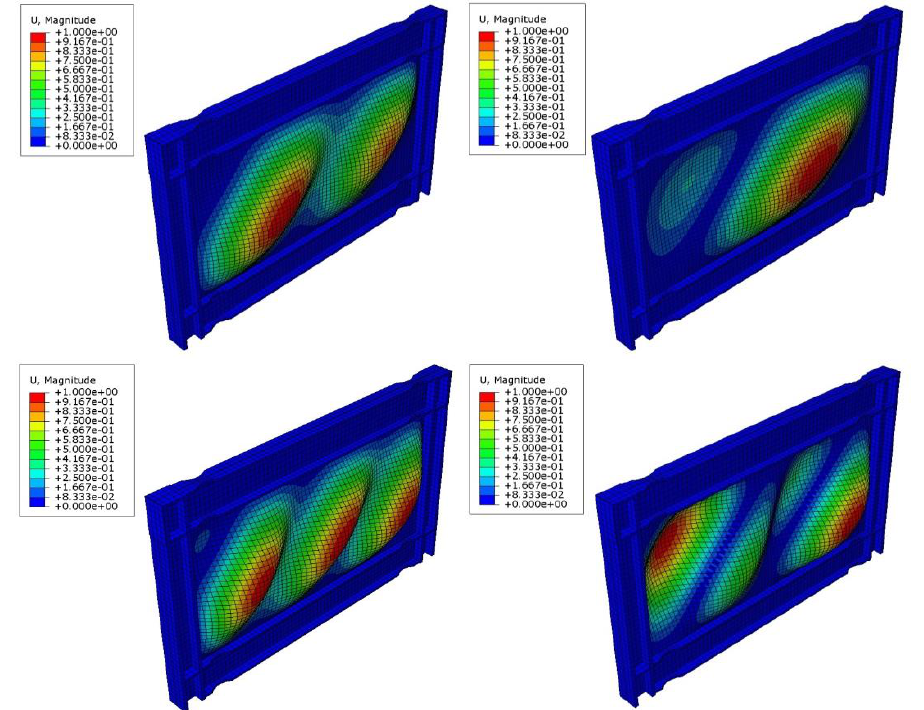
Fig. 3 . Buckling analysis of steel plate shear